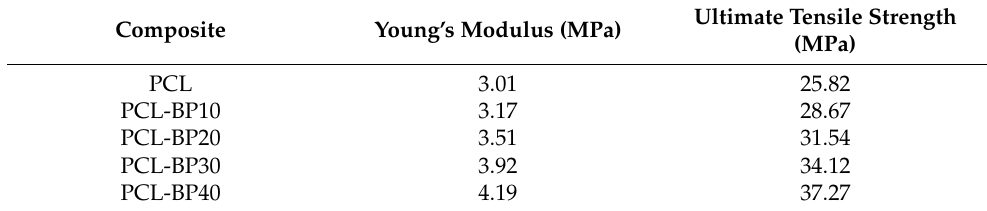
Table 2. Mechanical properties of PCL and PCL-BP composites.